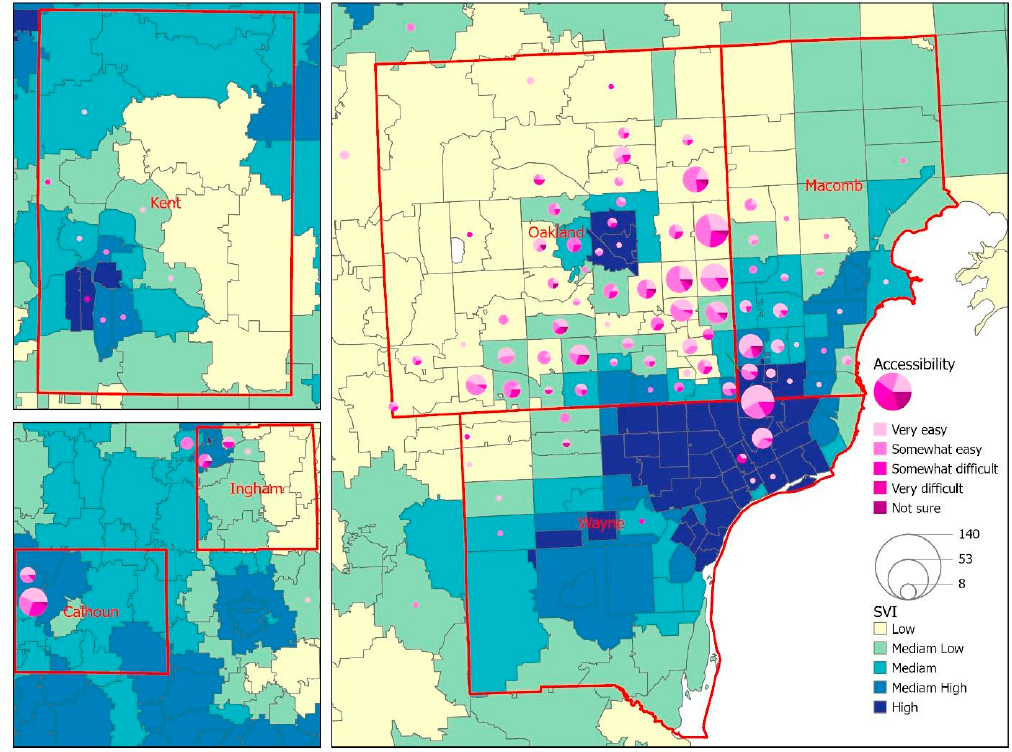
Figure 3. A map for the visualization of the overall SVI against the accessibility of COVID-19 vaccination among survey respondents.